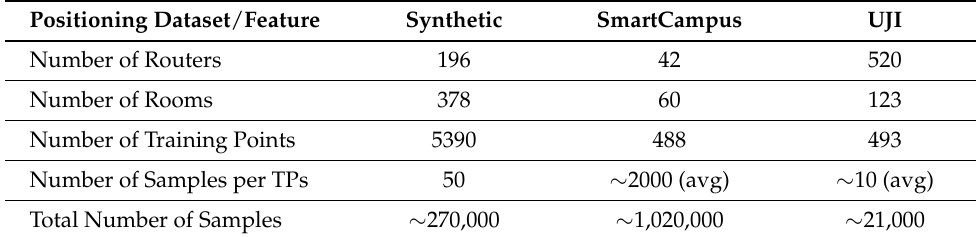
Table 1. Comparison among the three experimented IPS datasets. Positioning Dataset /